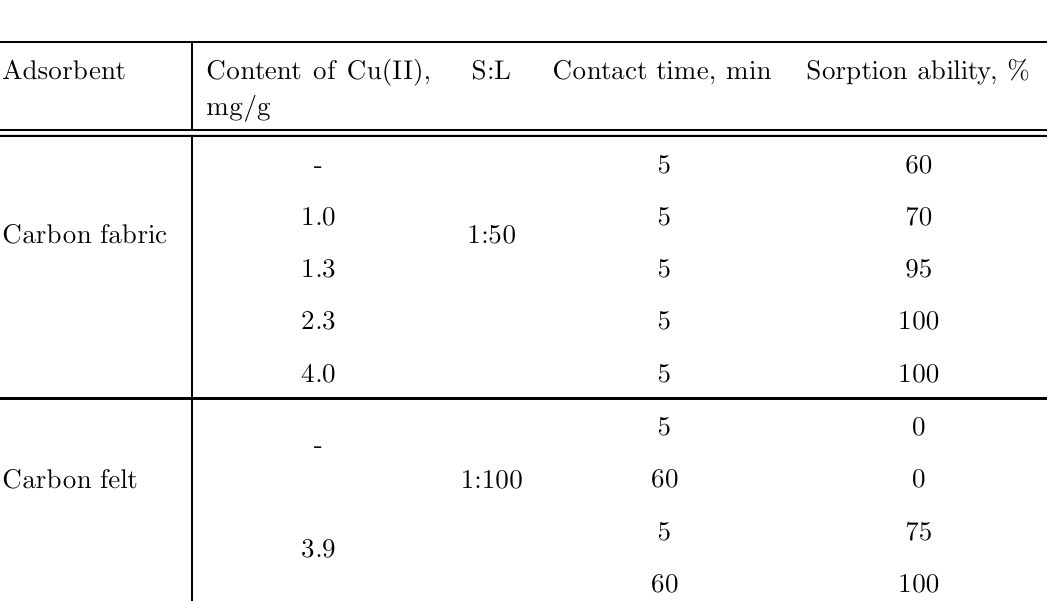
Table 1 The structure { sorptive characteristics of carbon materials